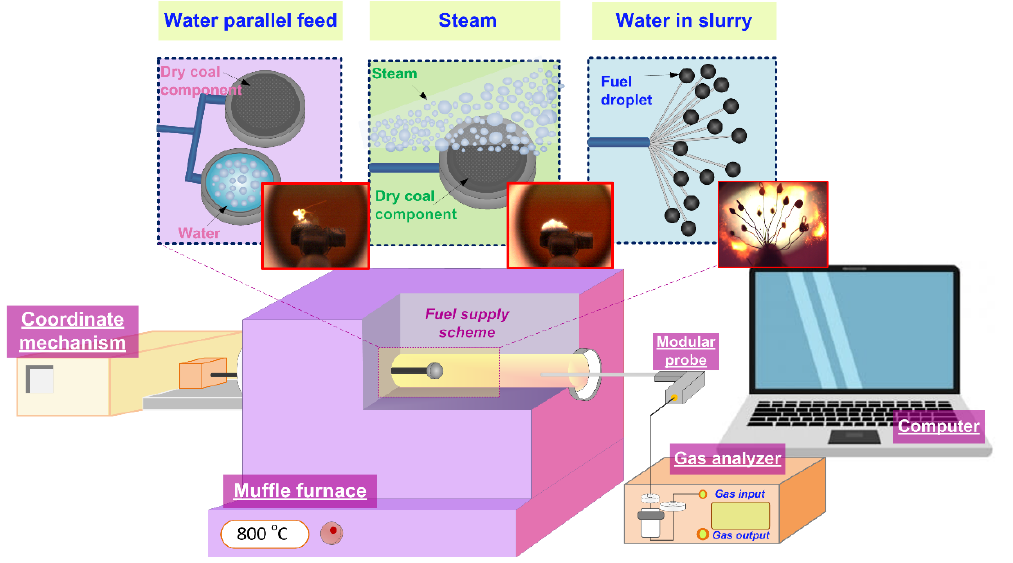
Figure 1. Experimental setup.